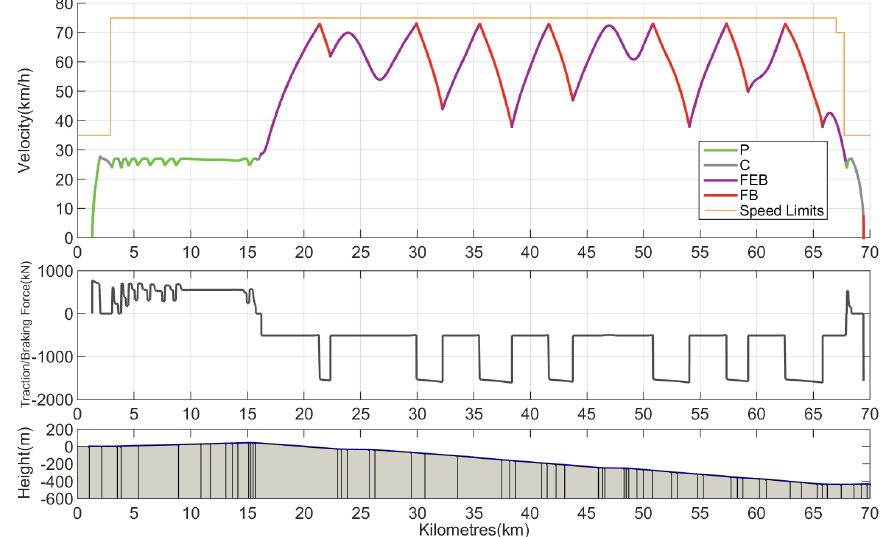
Figure 17. Speed profile of a freight train based on FPC (trip time: 95 min).